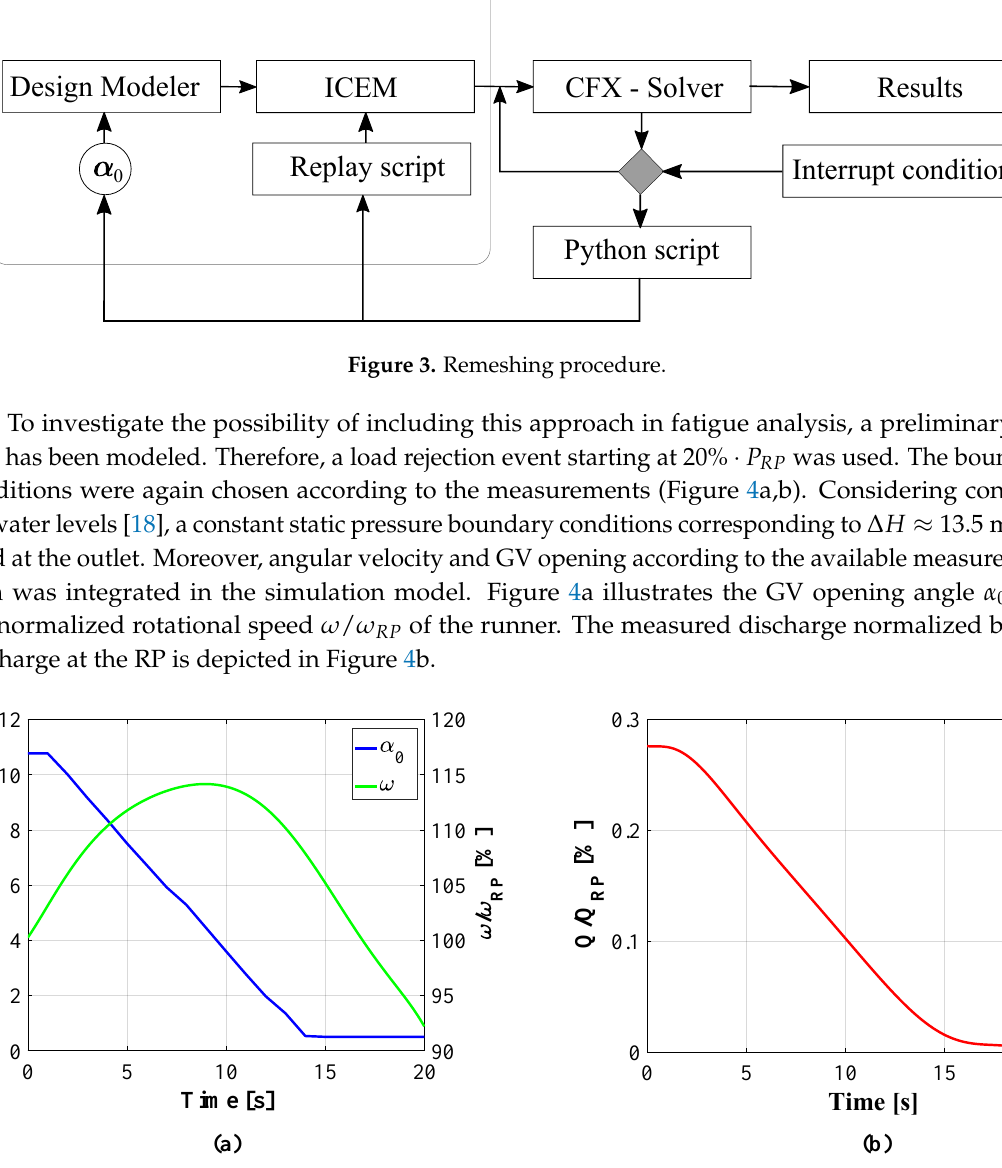
Figure 4. ( a ) measured values of the GV opening and angular velocity during load rejection and ( b ) discharge obtained by the Winter Kennedy